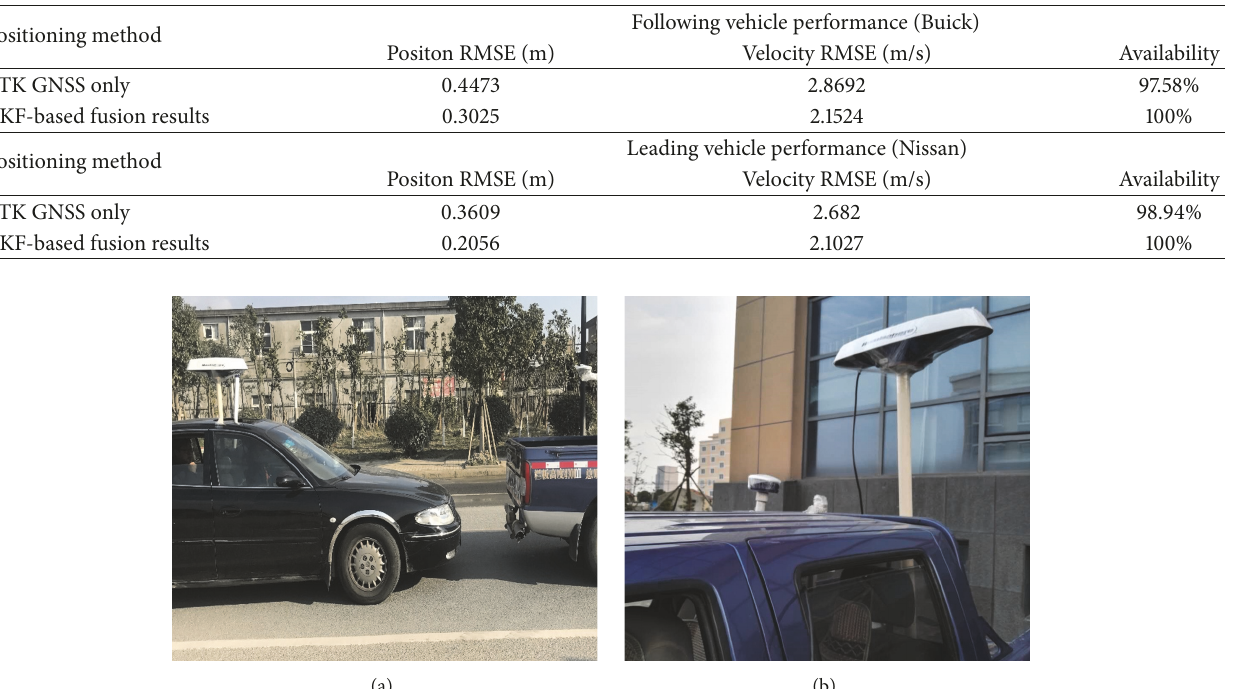
Table 1: The comparison of the navigation performance of the leading and following vehicles.